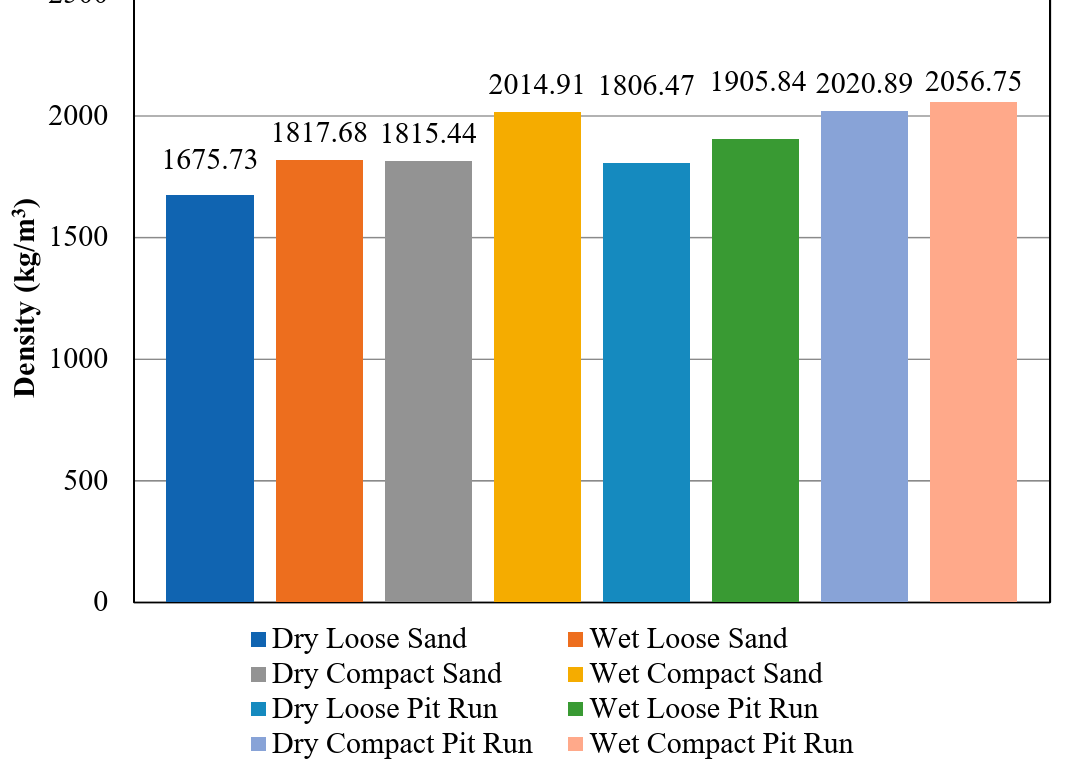
Figure 5. Density of soil samples.